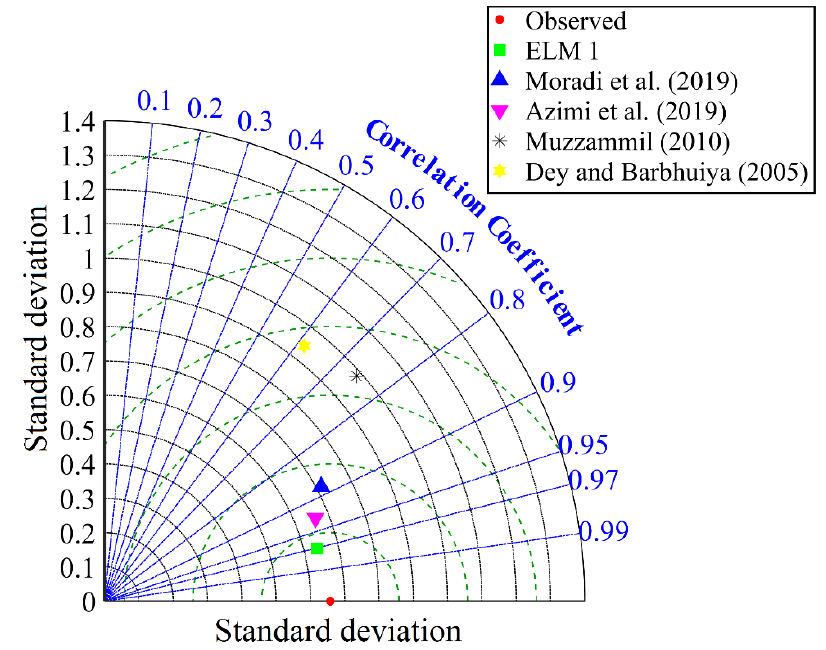
Figure 6. Comparison of the developed ELM model for abutment scour depth prediction with existing conventional and artificial intelligence (AI)-based techniques by combined accuracy ( CA ) index.